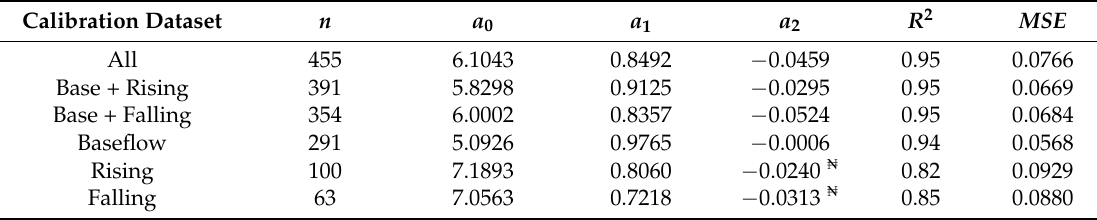
Table 1. Regression coefficients and goodness of fit for various calibration datasets from LOADEST.